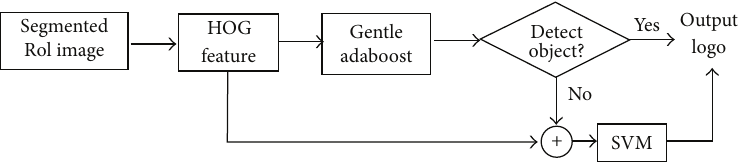
Figure 15: Cascaded classification scheme for logo detection.